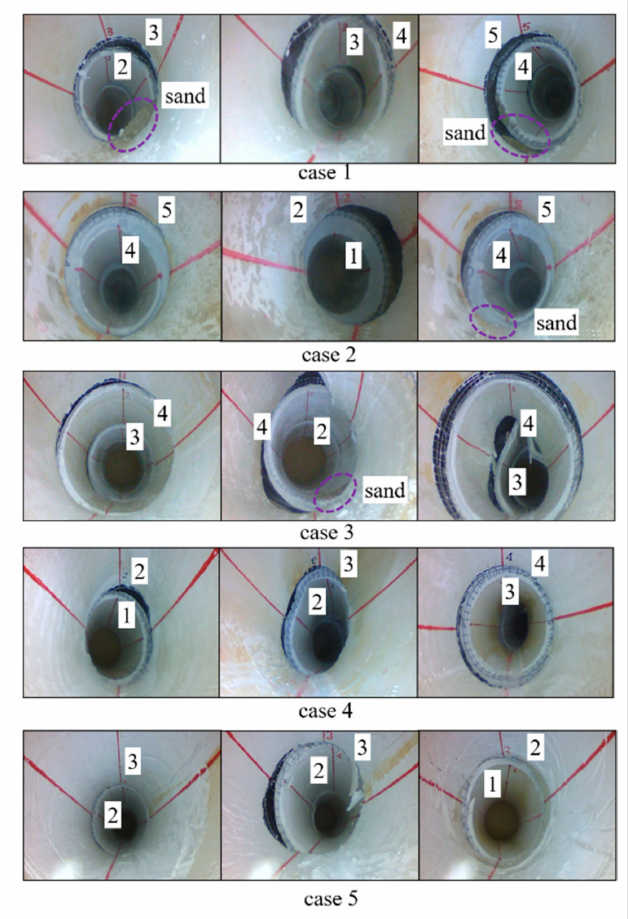
Figure 13. Damage pattern of the lining segments of each